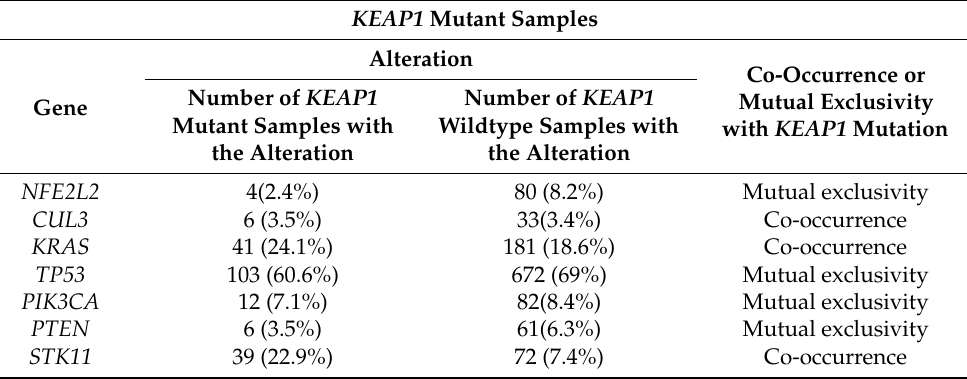
Table 4. KEAP1 mutations occur alongside mutations in other genes in NSCLC *.